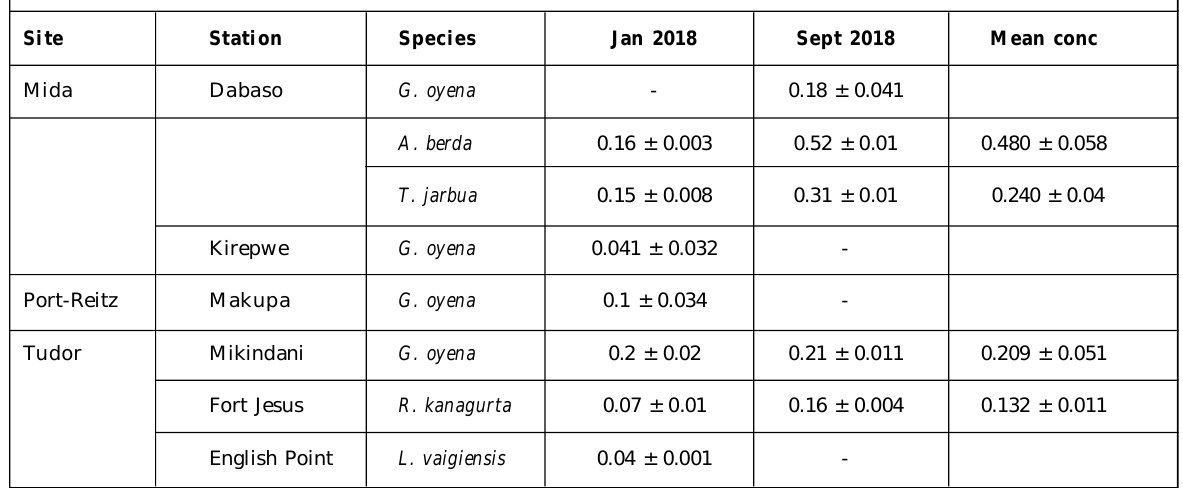
Table 5: Concentration of MPs (x ± SE) in the different species in different creeks and stations Site Station Species Mida Dabaso